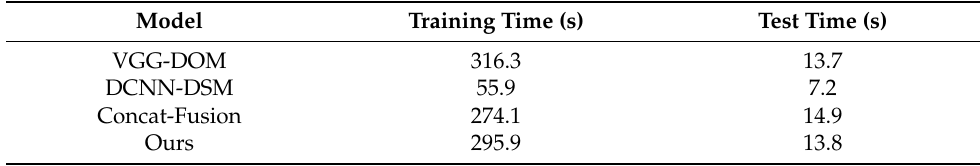
Table 6. Comparison of time